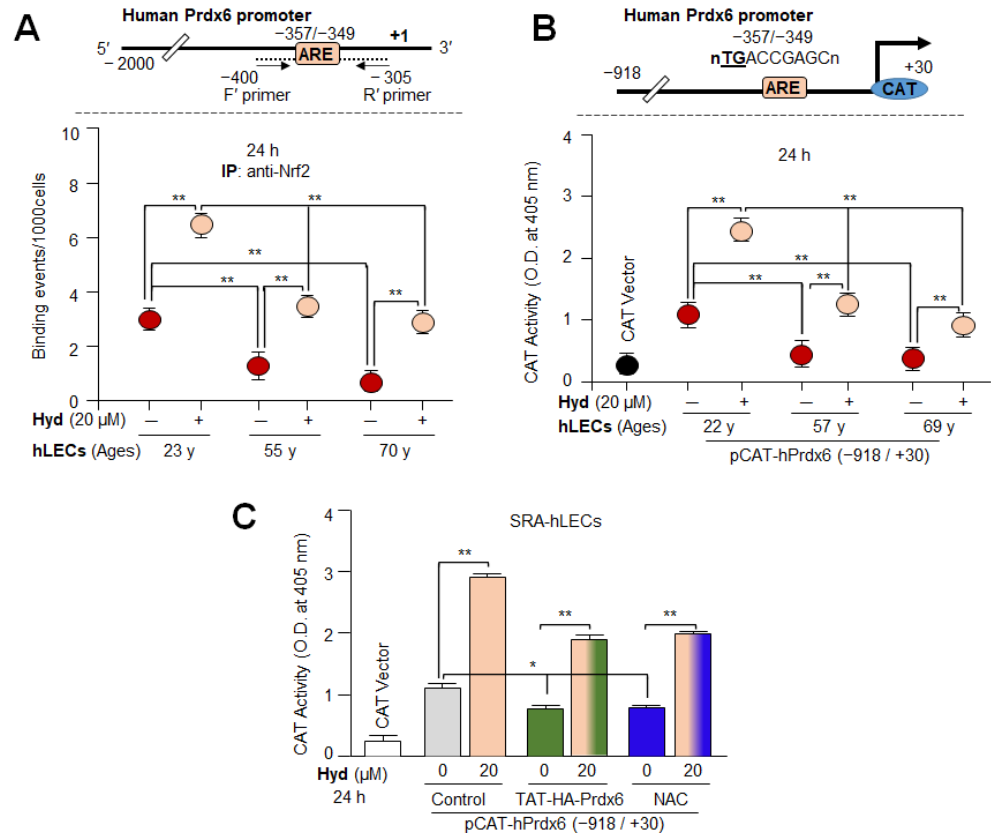
Figure 7. ( A ) In vivo DNA binding assay disclosed that Hyd reinforced binding activity of Nrf2 in aging hLECs. Upper panel, schematic illustration of Prdx6 gene promoter with ARE site and ChIP primer locations. Lower panel, in vivo DNA-binding (ChIP) assay revealed that Hyd reinforced the binding activity of Nrf2 to its ARE sequences of the Prdx6 promoter in aging hLECs. ChIP assay was conducted using ChIP grade antibody specific to Nrf2. Immunoprecipitated DNA fragments isolated from vehicle control or Hyd-treated different ages of primary hLECs were purified and processed for ChIP-RT-qPCR analysis. The reduction in Nrf2 enrichment at ARE site in untreated LECs, while increased abundance of Nrf2 at the ARE site in response to Hyd treatment, could be significantly eminent. Young (23 y) vs. aged (55 y and 70 y) subjects and untreated vs. Hyd treated, ** p < 0.001. ( B ) Age-related reduction in transcriptional activity of Prdx6 promoter in hLECs of variable ages was restored by Hyd. Top panel, diagrammatic sketch of the 5 ′ - constructs of hPrdx6 promoter ( − 918/+30 bps) linked to CAT reporter plasmid. Lower panel, CAT activity of Prdx6 promoter and CAT vector. The data represent the mean ± S.D. from three independent experiments. Younger age (22 y) vs. aging (57 y and 69 y) samples; untreated vs. Hyd-treated hLECs; ** p < 0.001. ( C ) Hyd- mediated Nrf2 activation of Prdx6 gene promoter was ROS independent. Hyd treatment significantly increased the Prdx6 promoter activity in a dose-dependent manner. The ARE-driven Prdx6 promoter activity was decreased in SRA-hLECs treated with TAT-HA-Prdx6 (10 µ g/mL) protein or antioxidant molecules N-acetyl cysteine (NAC, 5 m M) alone for 24 h. At the same time, Prdx6 transcription increased in SRA-hLECs when cotreated with TAT-HA-Prdx6 protein or NAC and Hyd. The data represent the mean ± S.D. from three independent experiments. * p < 0.05; ** p <